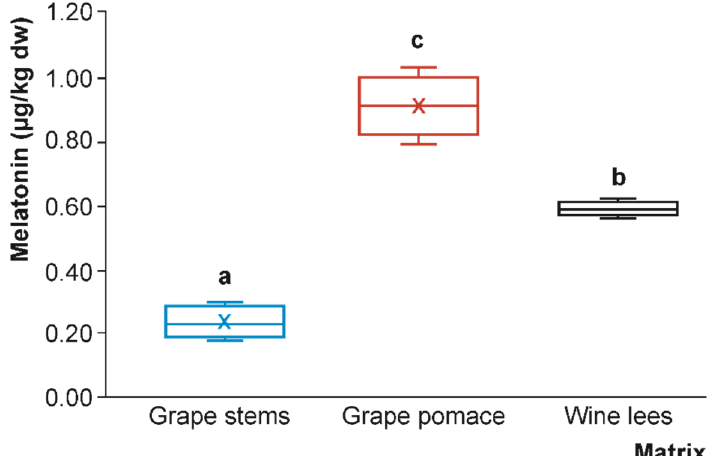
Figure 4. Box plots with quartiles (upper values of 75%, median values of 50%, and lower values of 25%) of melatonin present in grape stems (blue box), grape pomace (red box), and wine lees (black box) ( µ g/kg dry weight (dw)) ( n = 4 for each by-product). Boxes with a different letter within each plot were statistically different at the significant level of p < 0.05, according to the analysis of variance (ANOVA) and Tukey’s multiple range test.